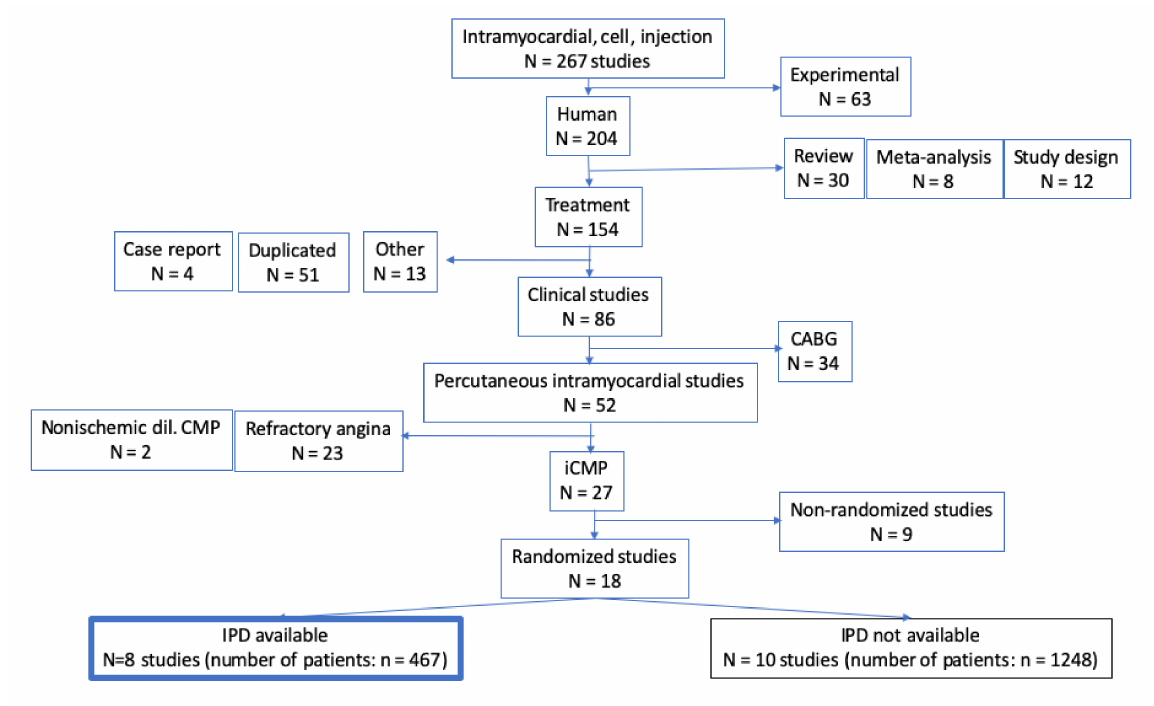
Figure 1. Search strategies: excluded and included